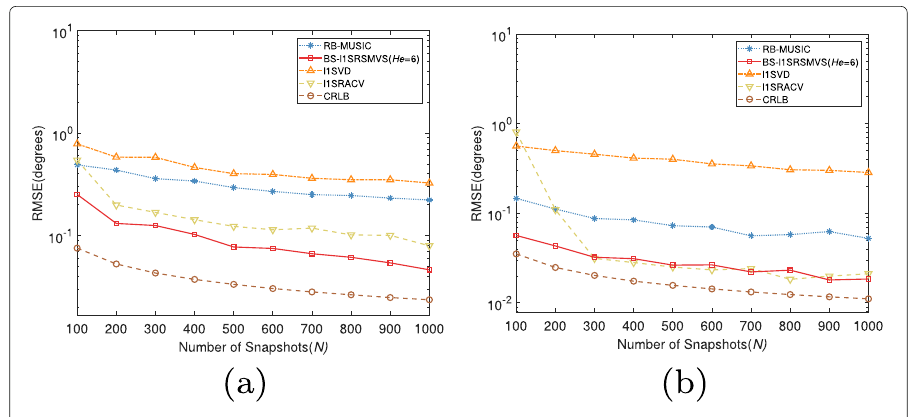
Fig. 6 RMSEs versus snapshots with RB-MUSIC, BS- (cid:2) 1 -SRSMVS, (cid:2) 1 -SVD, (cid:2) 1 -SRACV and CRLB. a M =13, SNR=0dB. b M =13,